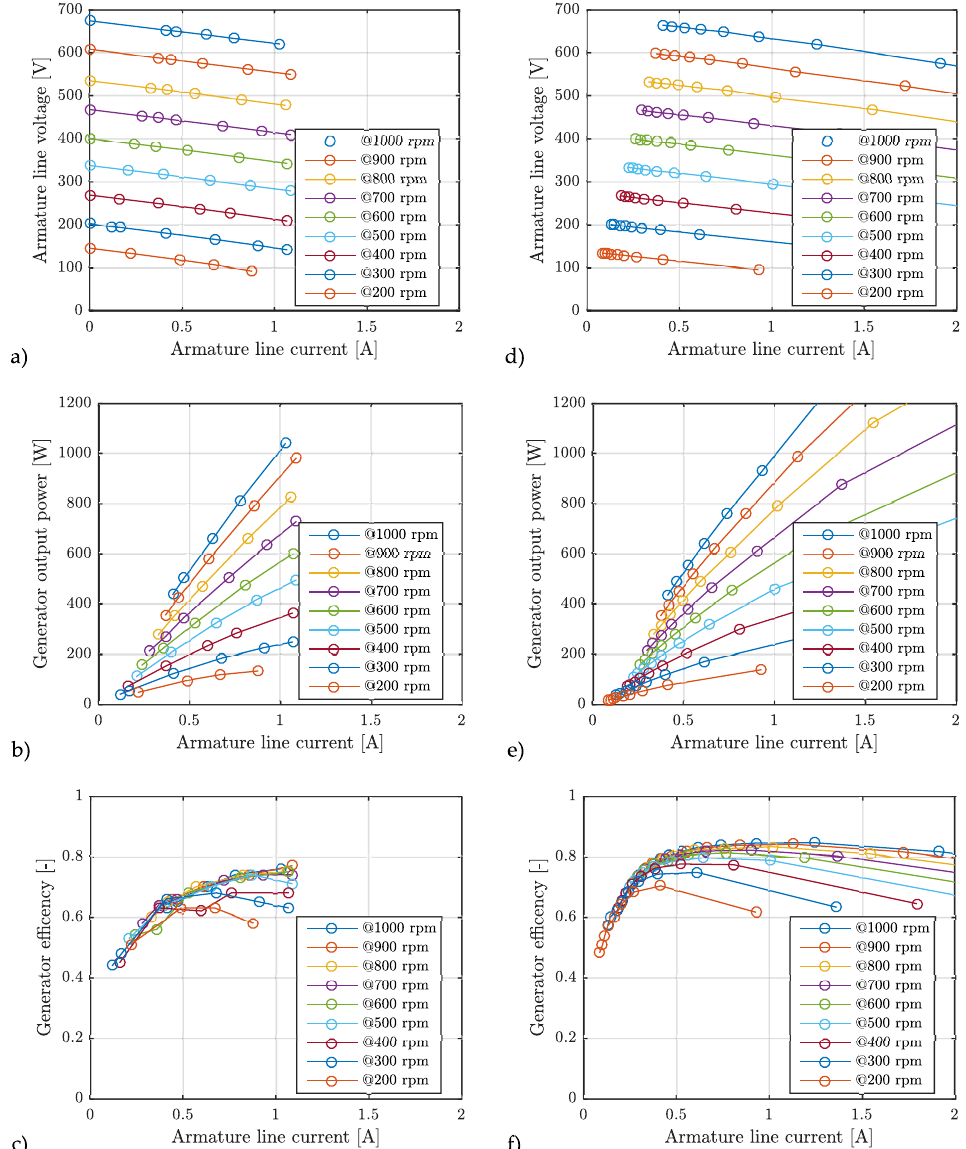
Figure 15. FEM simulation and measurements results: ( a ) measured machine voltage, ( b ) measured machine output electrical power, ( c ) measured machine efficiency, ( d ) simulated machine voltage, ( e ) simulated machine output electrical power, ( f ) simulated machine